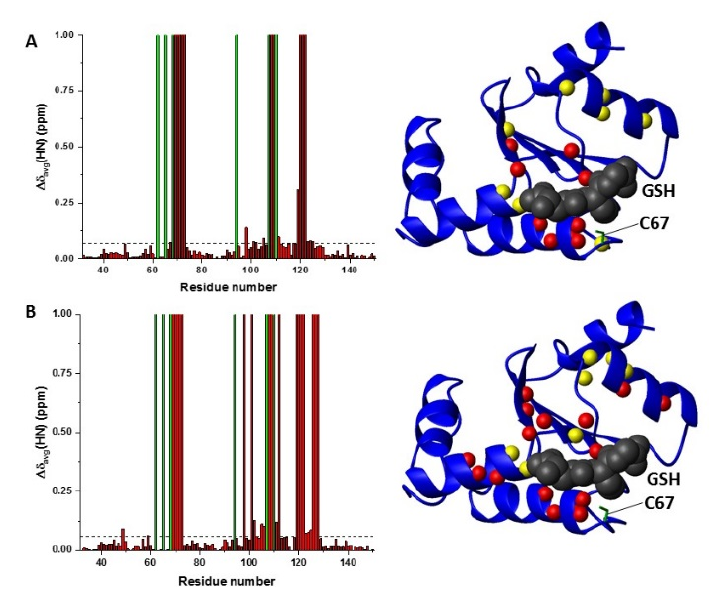
Figure 4. Mapping NMR chemical shift changes on GLRX5 upon apo hetero-complex formation. ( A ) Backbone weighted average chemical shift differences (Δδ avg (HN)) on 15 N-labelled GLRX5 (800 μM starting protein concentration) upon complex formation with BOLA3 (left panel). Meaningful chemical shift differences were mapped on the solution structure of GSH-bound GLRX5 (PDB 2WUL) (right panel). ( B ) Δδ avg (HN) on 15 N-labelled GLRX5 (800 μM starting protein concentration) upon hetero-complex formation with C59Y BOLA3 (left panel). Meaningful chemical shift differences were mapped on the solution structure of GSH-bound GLRX5 (PDB 2WUL) (right panel). Red bars with Δδ avg (HN) = 1 indicate residues whose backbone NH signals broaden beyond detection. The green bars indicate proline residues or unassigned NHs. Chemical shift threshold values (see the Materials and Methods section) are indicated as dashed lines. On the blue ribbon diagrams, backbone NHs showing line broadening beyond detection are depicted as red spheres, and the backbone NHs with chemical shifts above the thresholds are depicted as yellow spheres. The sidechain of Cys67 is depicted as green stick, and the GSH molecule is depicted as CPK mode in gray.